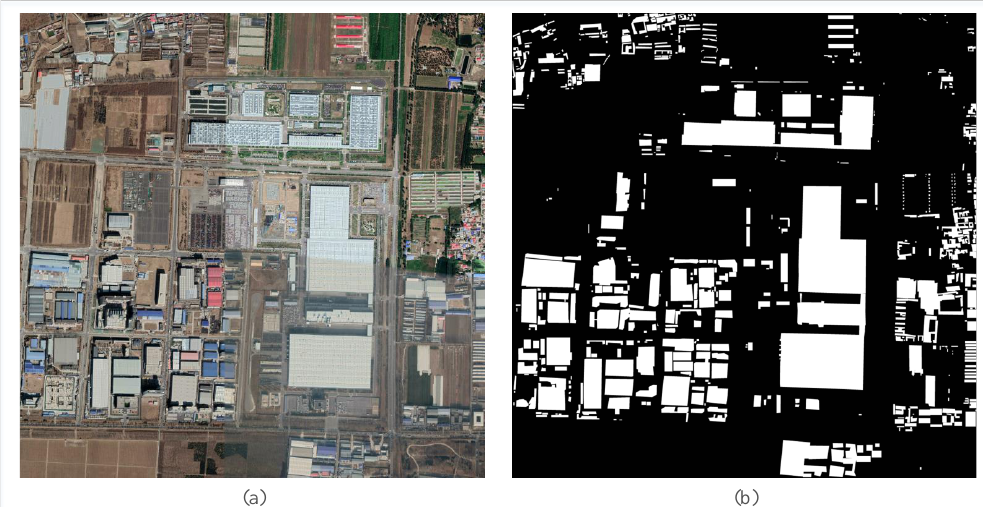
Figure 1. Example image from the Beijing building dataset (BBD), ( a ) is original data, and ( b ) is the associated